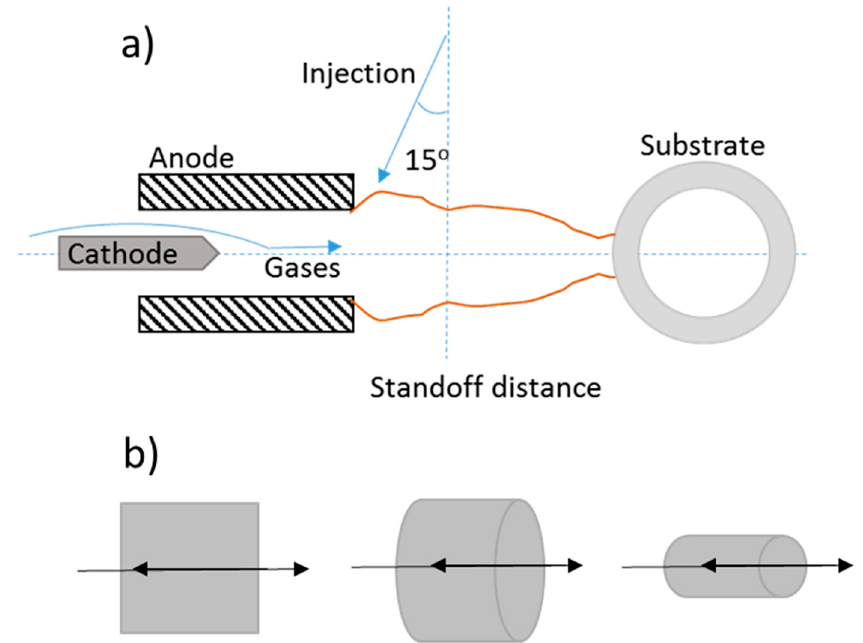
Figure 8. Schematic of the spray setup in the cylindrical sample: a ) suspension injection into the plasma get; b ) torch movement direction.